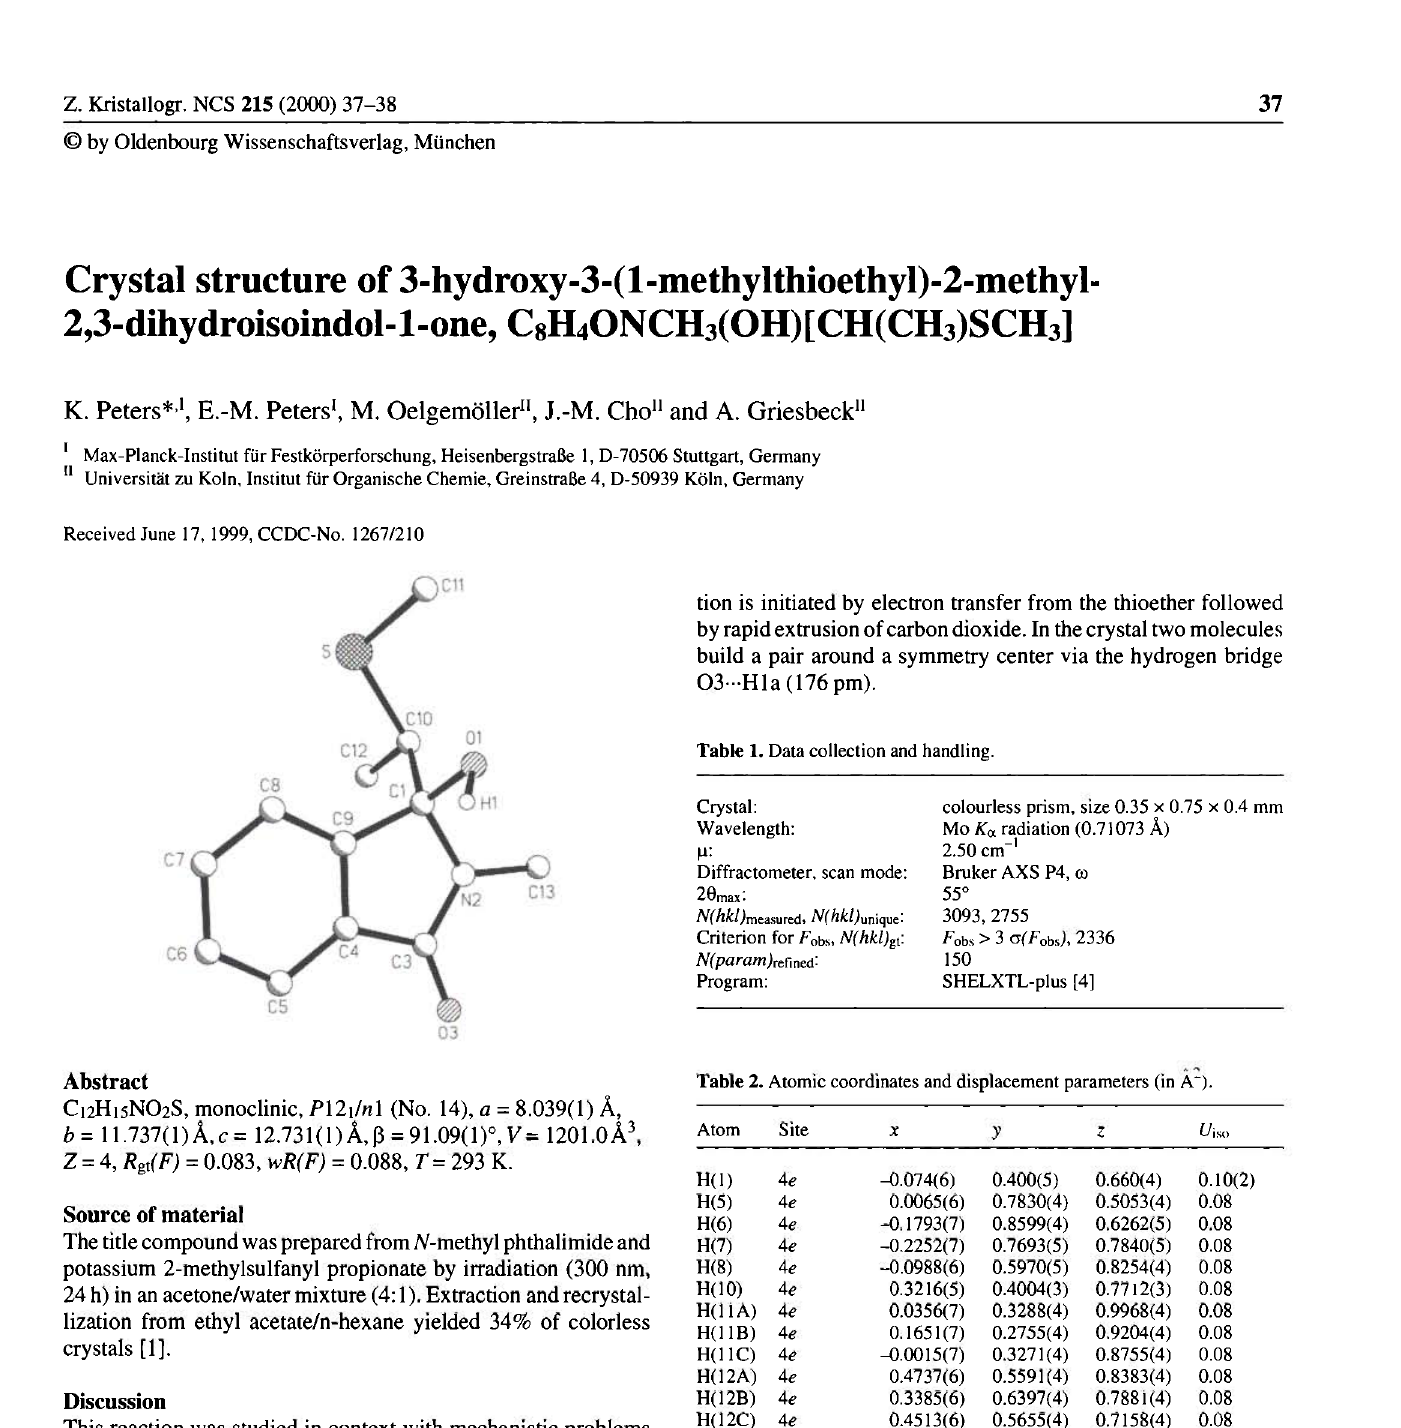
Table 3. Atomic coordinates and displacement parameters (in k 2